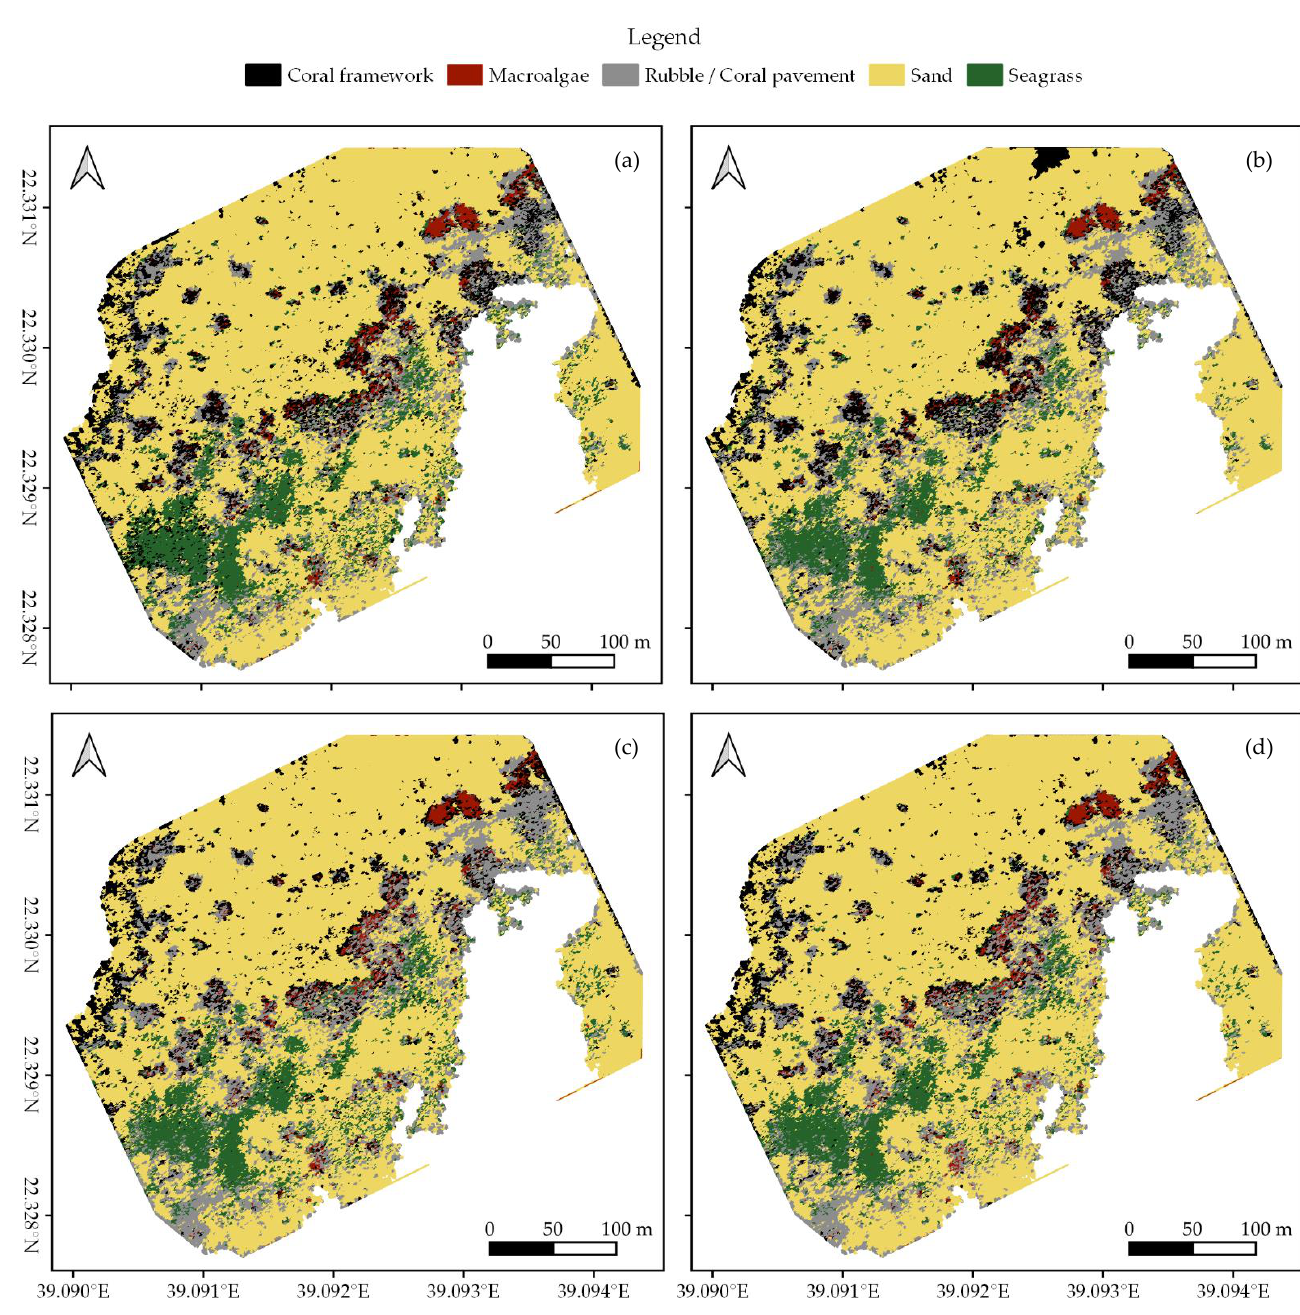
Figure 5. Habitat classifications of Area 3 (Figure 1) for classification protocol ( a ) 1. ‘Traditional classification’; ( b ) 2. ‘Using reef zones’; ( c ) 3. ‘Using geomorphometric features’; ( d ) 4. ‘Reef zones and geomorphometric features’ (Table 2).